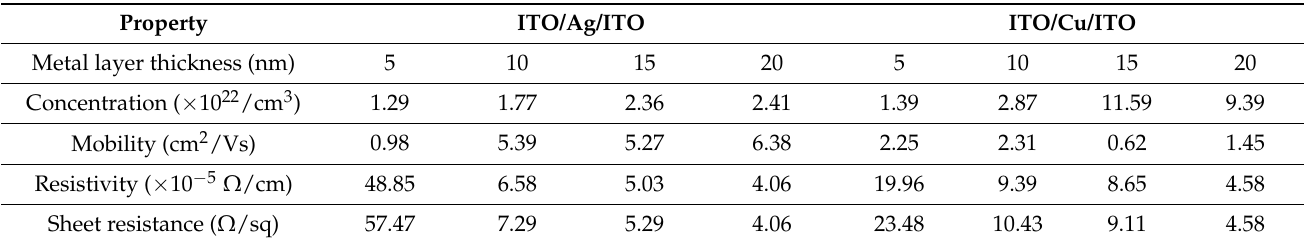
Table 2. Electrical properties of ITO/Ag/ITO and ITO/Cu/ITO films on PEN substrate as functions of the Ag and Cu interlayer thickness on the PEN